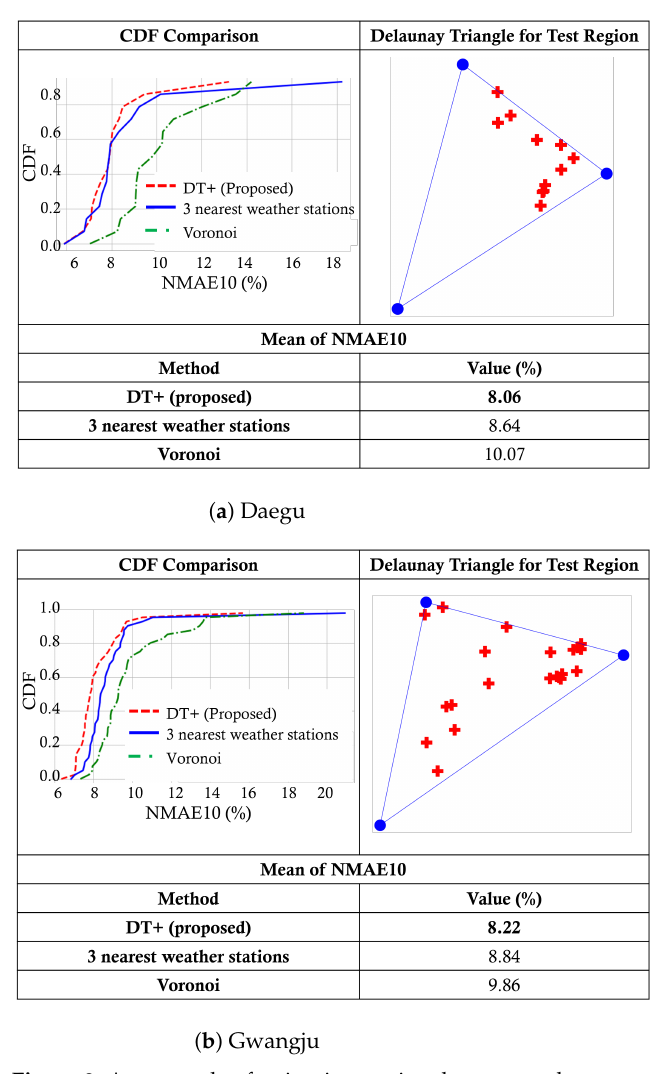
Figure 9. An example of union-inner triangles test